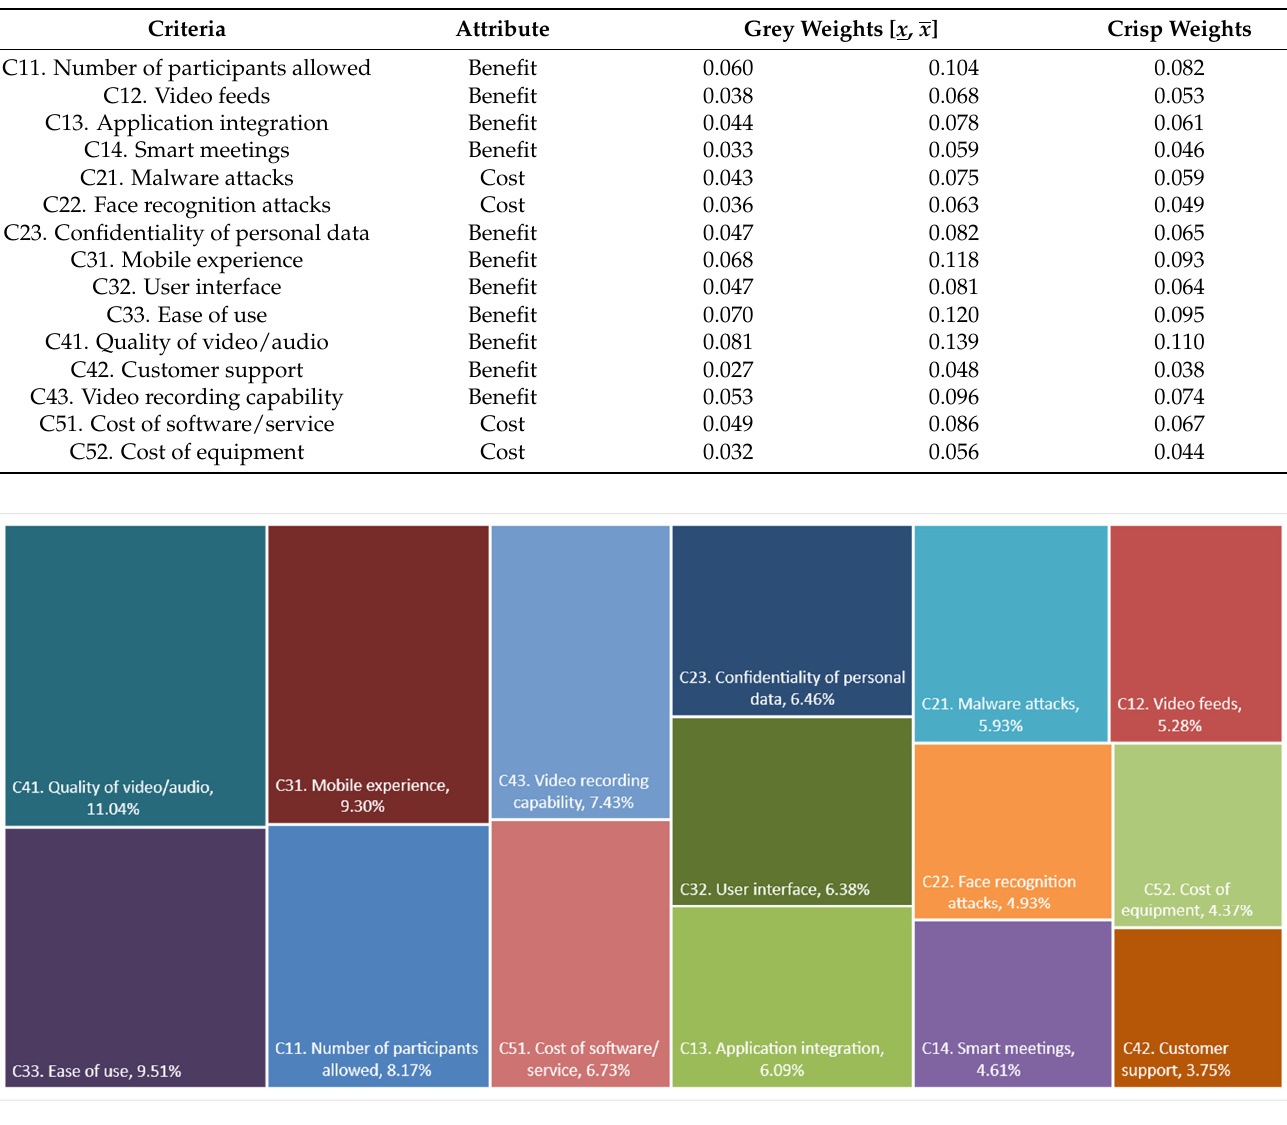
Table 8. The grey weights of G-AHP.